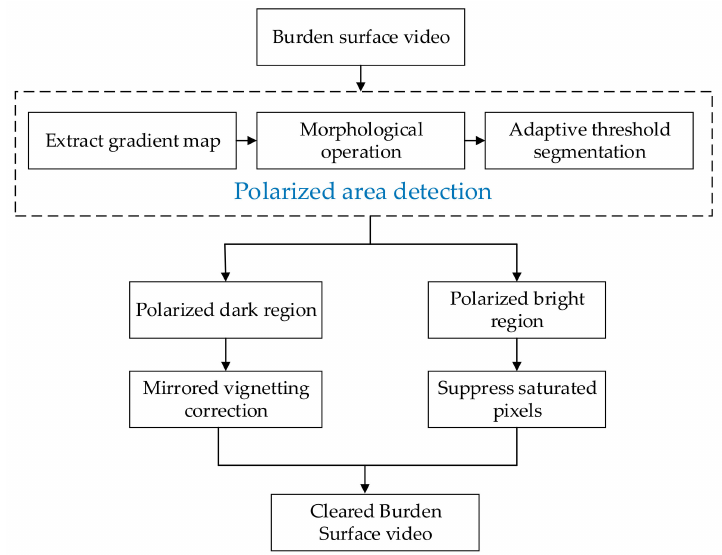
Figure 13. Micro-pixel luminance polarization